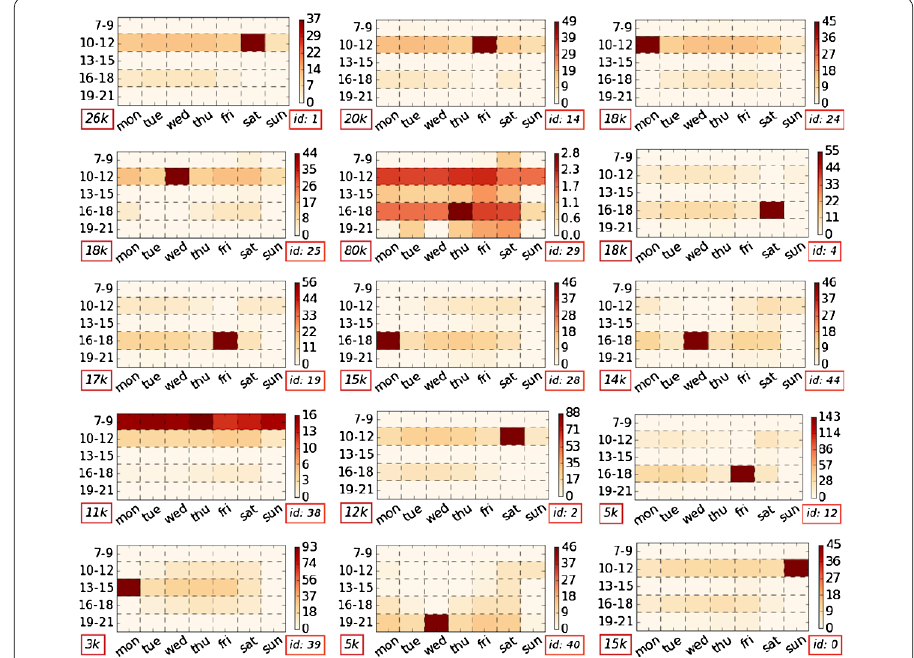
Figure 7 Collective temporal purchasing footprints. Selection of the 45 collective temporal purchasing footprints depicted as heatmaps: the darker the color, the higher the total amount spent (in € ). On the x axis are reported the days of the week, while on the y axis are reported the five time